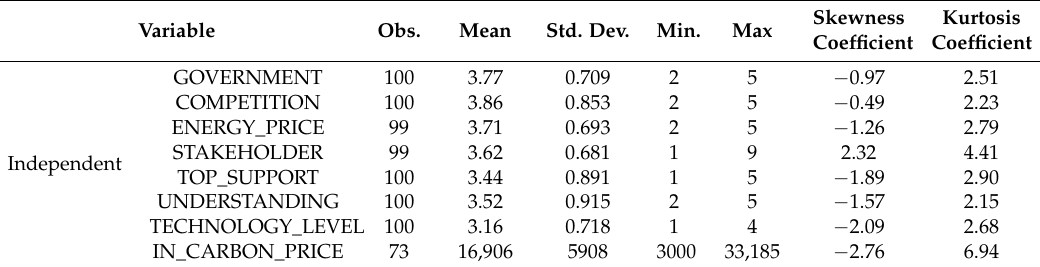
Table 6. Statistical summary of independent variables.